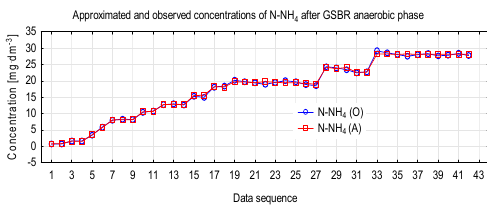
Figure 3. Approximated and observed concentrations of N-NH 4 after sequence bath reactor with aerobic granular activated sludge (GSBR) anaerobic